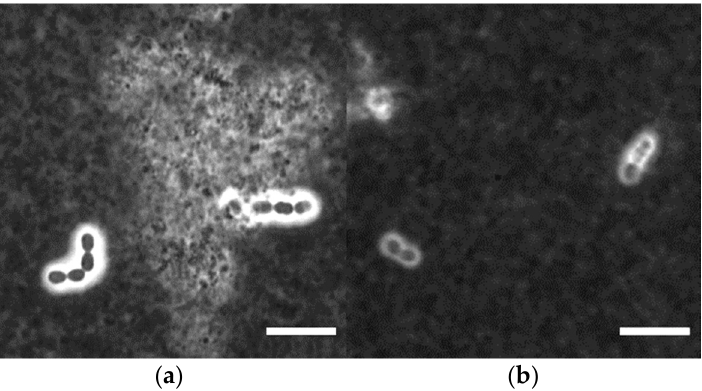
Figure 1. Light micrographs of stirred milk gels fermented with S. thermophilus ( a ) ST-1G or ( b ) ST-2E after dilution with deionized water and negative staining with Indian ink. Light areas around the cells indicate capsular EPS, in the background are ink and gel particles. Scale bar: 10 µm.